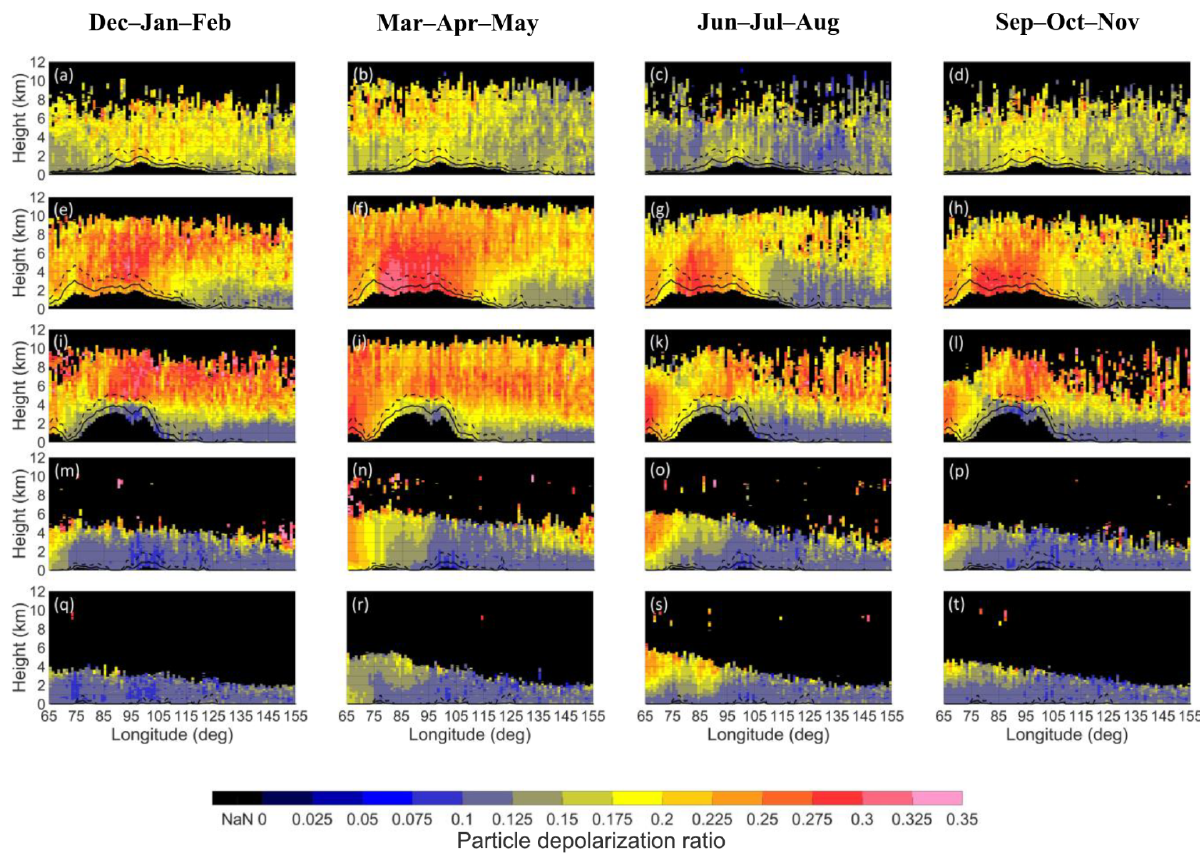
Figure 7. Zonal distribution of the conditional dust depolarization ratio profiles for the regions with longitude from 65 to 155 ◦ E and latitudes 45 to 55 ◦ N (a–d) , 35 to 45 ◦ N (e–h) , 25 to 35 ◦ N (i–l) , 15 to 25 ◦ N (m–p) , and 5 to 15 ◦ N (q–t) ; profiles are presented as 3-month averages: December–January–February (a, e, i, m, q) , March–April–May (b, f, j, n, r) , June–July–August (c, j, k, o, s) and September–October– November (d, h, l, p, t) . The minimum terrain elevation is denoted with black colour. The black continuous (dashed) line refers to the mean (max) elevation of the